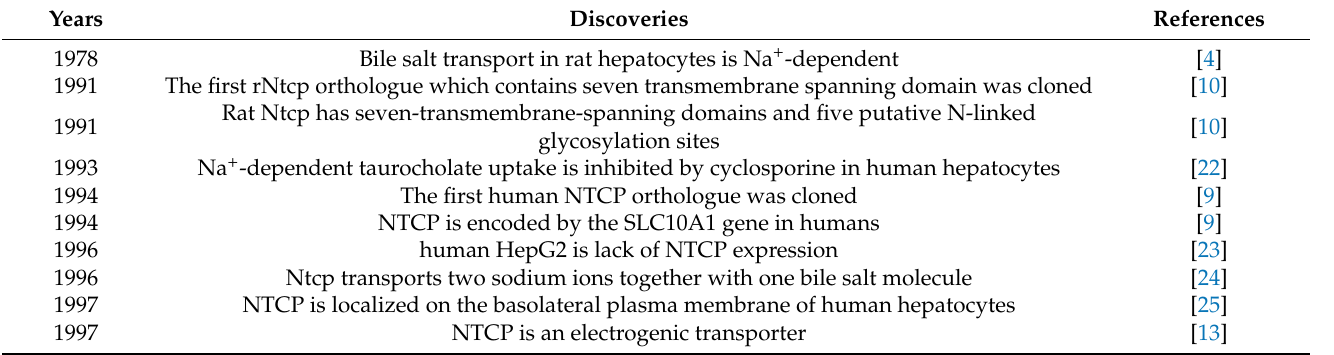
Table 1. Discoveries in